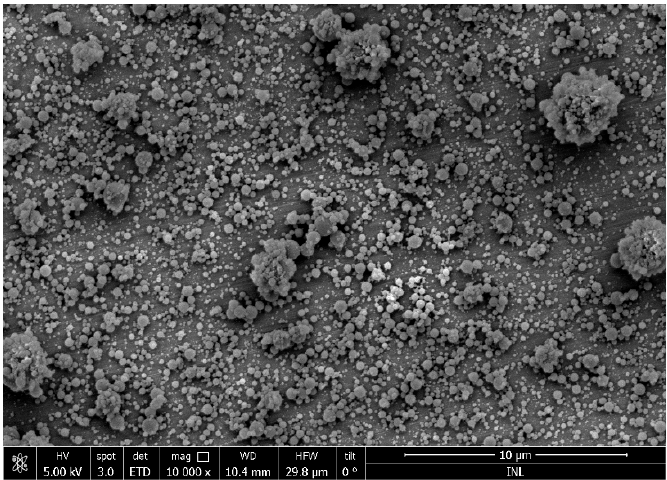
Figure 2. Lactoferrin particles at the submicron scale produced by electrospray. The image was obtained by scanning electron microscopy.